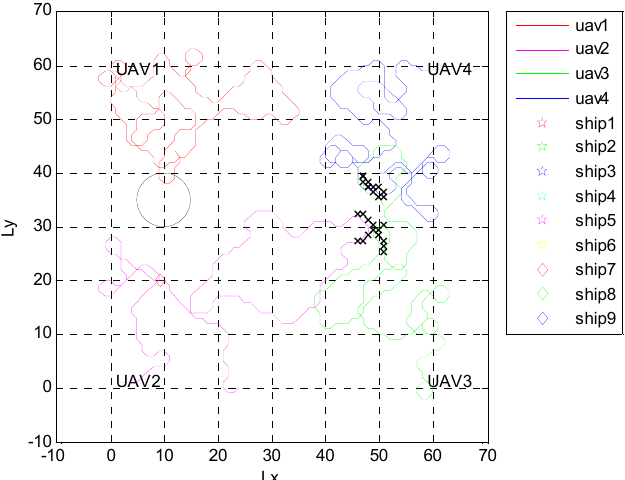
Figure 2. Reinforcement learning (RL) search initial stage.